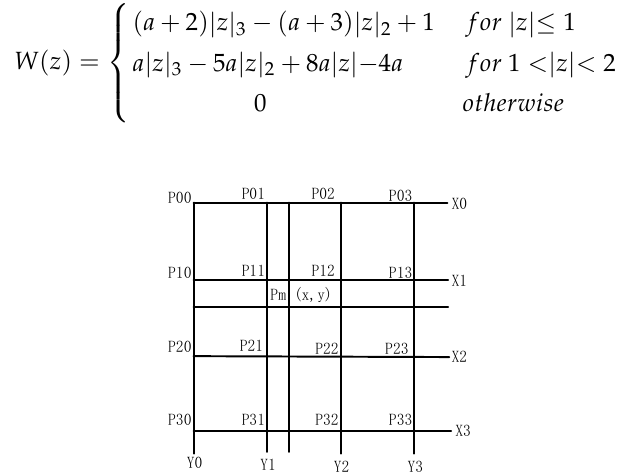
Figure 4. The bicubic interpolation of the grid map.